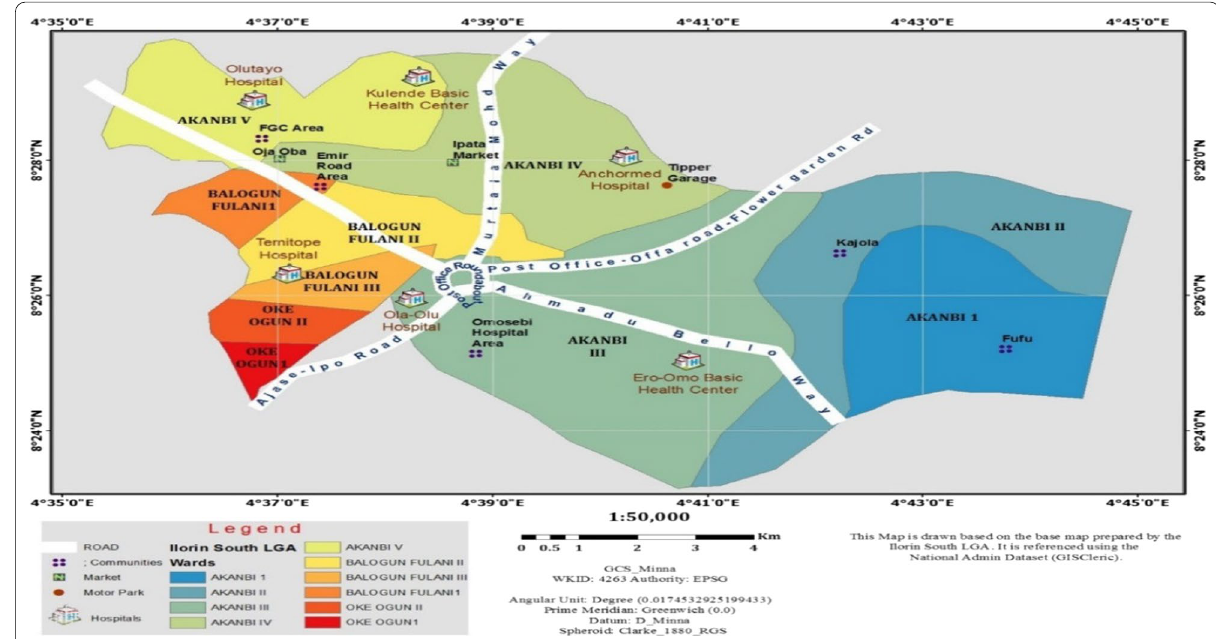
Fig. 1 Map of Ilorin South showing the traditional wards Source Author’s Fieldwork